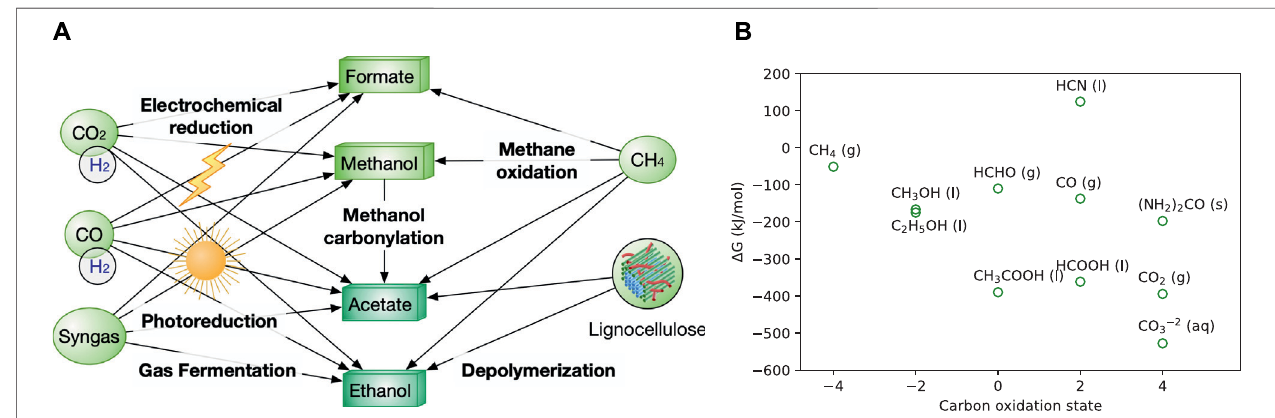
FIGURE 1 | (A) Production network among various C1 and C2 feedstocks. CO 2 and lignocellulosic biomass serve as the two ultimate carbon sources for all the liquidfeedstocks.H 2 isusedforthereductionofCO 2 andCO.O 2 isrequiredfortheoxidizationofmethanetoproducemethanolandformate.Gaseousfeedstocks(CO 2 , CO, H 2 ) are in circles, while liquid feedstocks (methanol, formate) are in boxes. The formats of below fi gures are the same in colour and shapes. (B) Free energy and the oxidation state of C1 and C2 species (Aresta et al., 2014). Synonyms: g, gas; l, liquid, s, solid; aq,